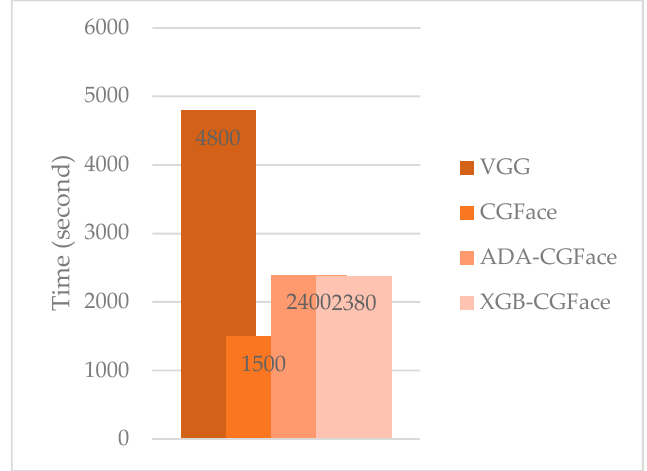
Figure 11. The time complexity between the proposed models and other models.